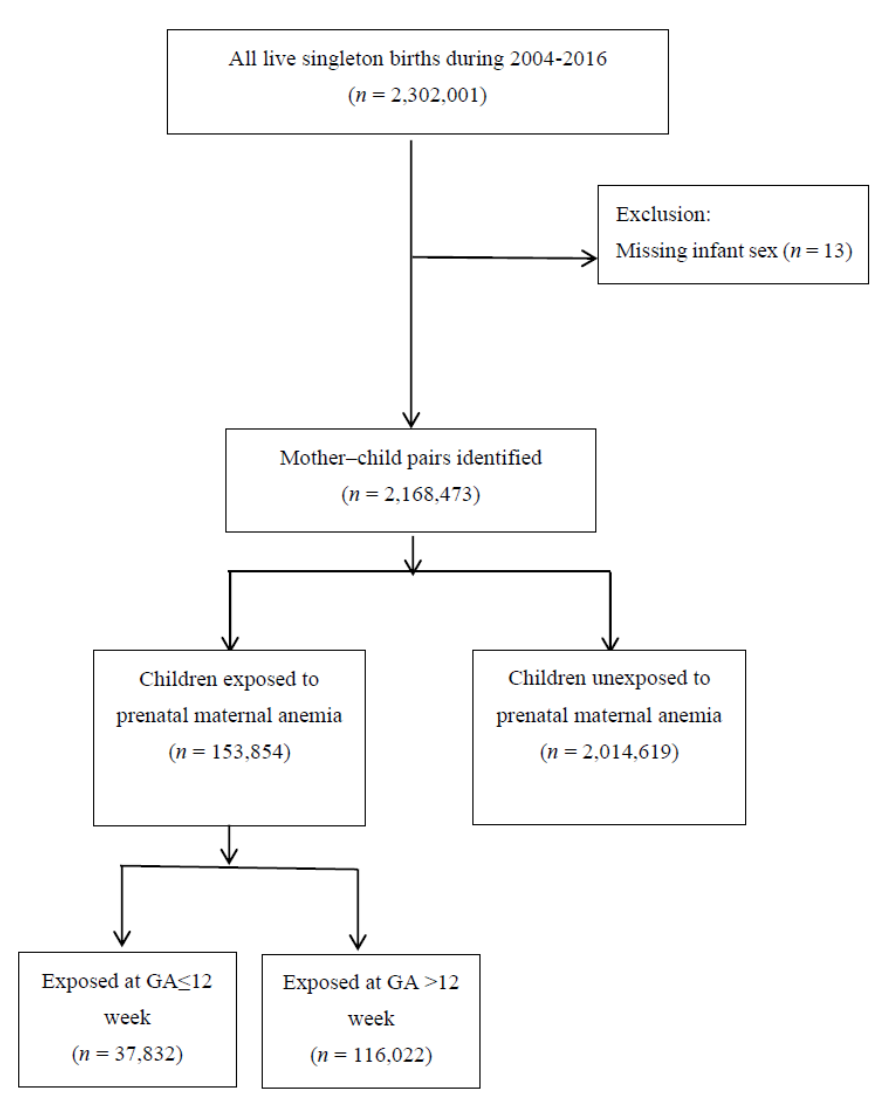
Figure 1. Overview of the design of this study (GA: gestational age).